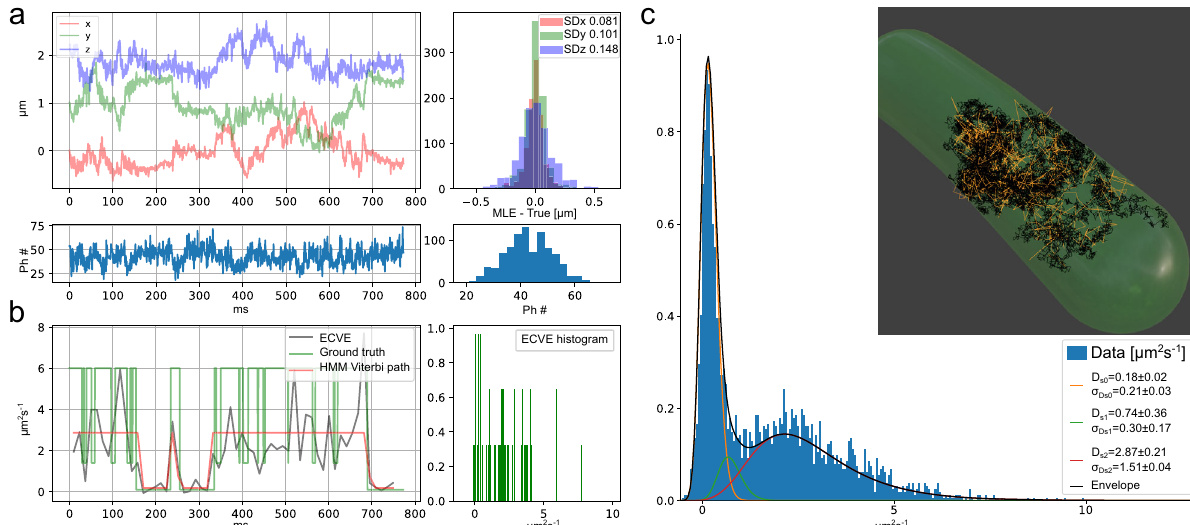
Fig. 3 | Tracking simulation in an E. coli -like geometry. Example trajectory with HMManalysisof100simulatedtrajectories. a Upperleft;exampletrajectorywith x (red) y (green) z (blue) estimatedposition coordinates withcorresponding photon counts(bottom).Upperright;thedeviationawayfromgroundtruthwiththeSDof the distribution in the legend, (bottom) is the photon count distribution. b Left; ECVE diffusion point estimation (gray) along the trajectory in ( a ), ground truth diffusion is in green, and the HMM prediction in red. Right; the distribution of